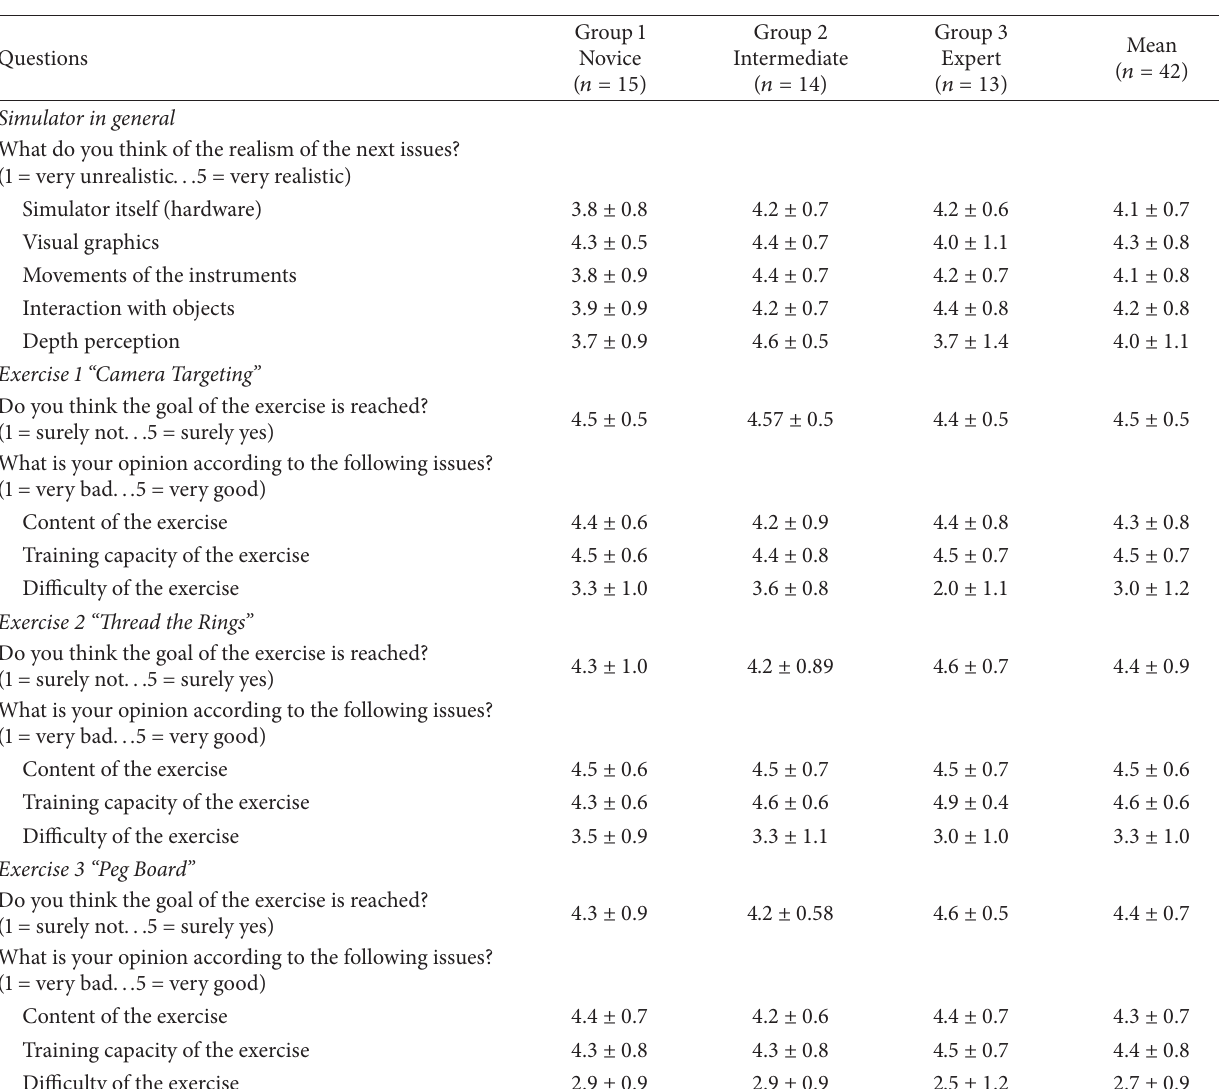
Table 3: Face validity (simulator and